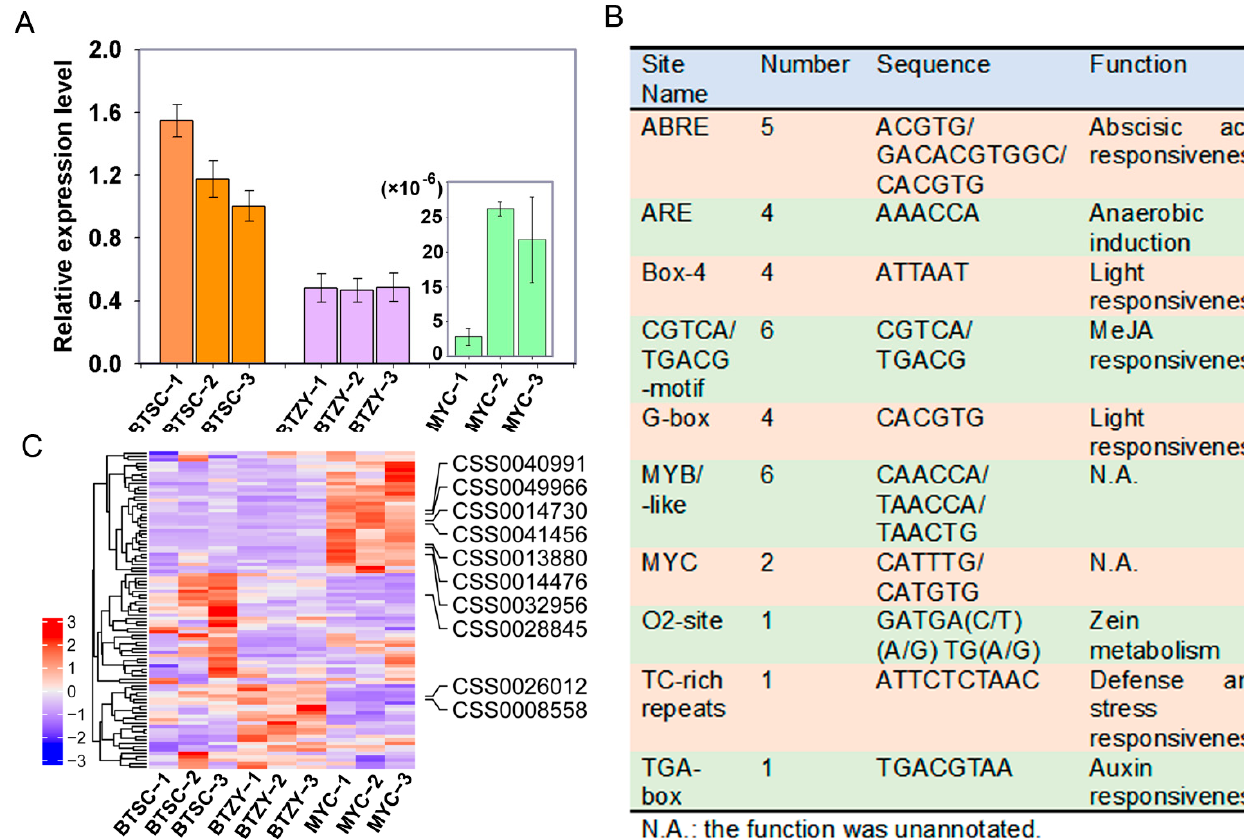
Figure 6. The expression pattern of TCS1 and promoter elements analysis. ( A )The relative expression level of TCS1 in three sample groups; ( B ) Analyses of promoter elements of TCS1 ; ( C ) The expression pattern of MYB family genes.